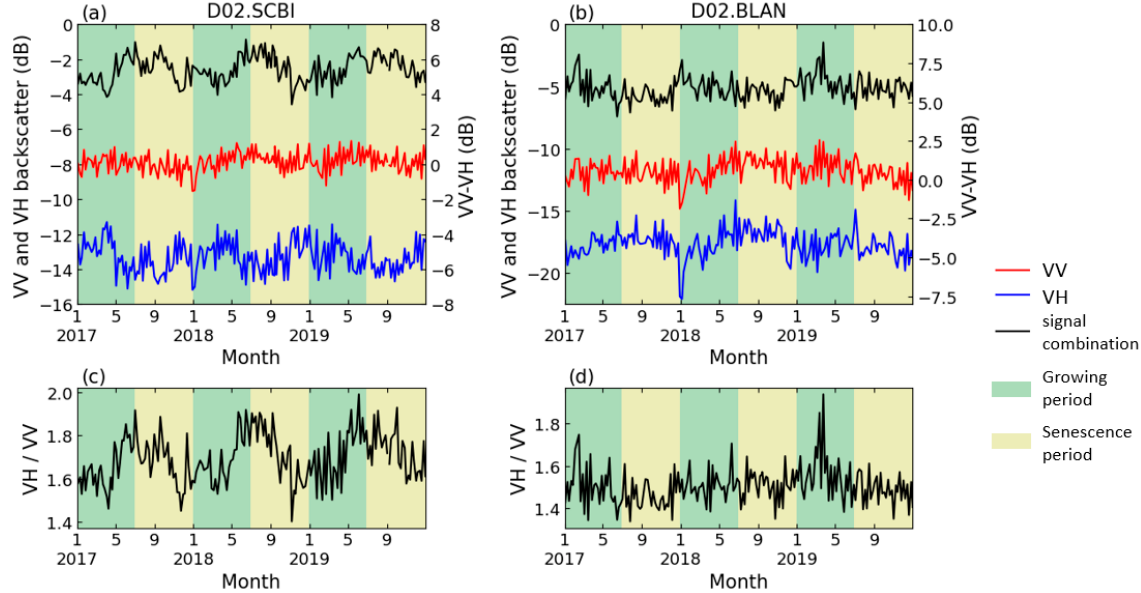
Figure 4. Backscatter coefficient of S1 dual polarization in ( a , c ). D02.SCBI (a deciduous site); ( b , d ). D02.BLAN (a coniferous site).